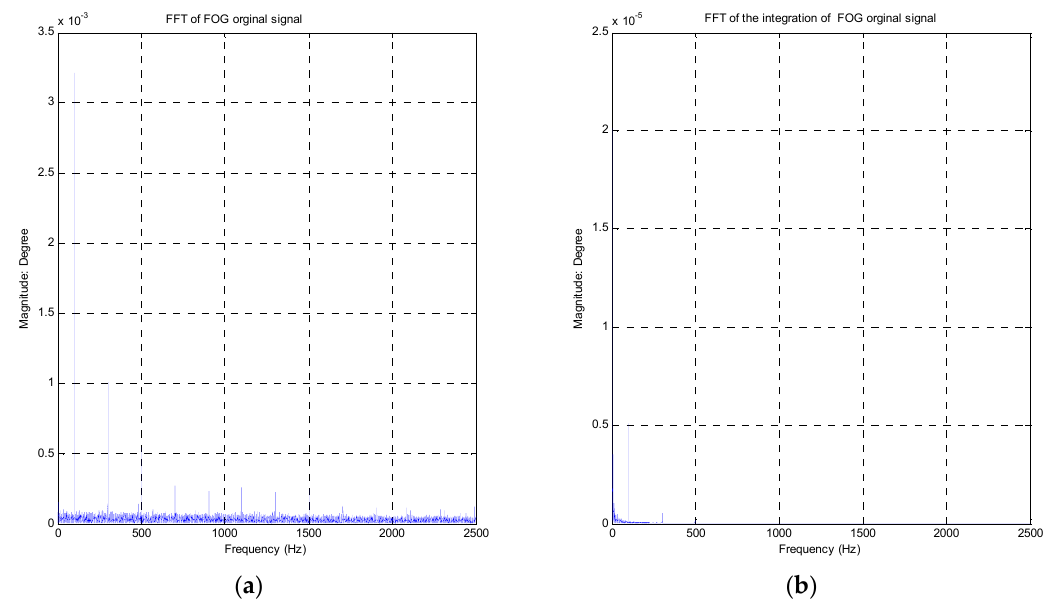
Figure 4. FOG Noise Characteristics ( a ) The FOG original signal; ( b ) The integration signal of the FOG.